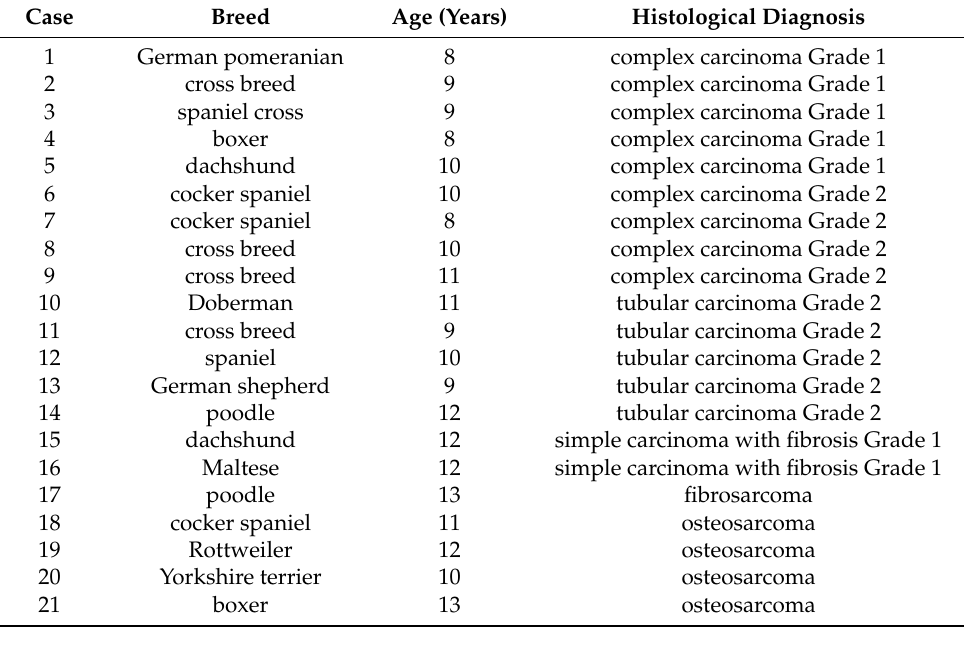
Table 2. Characteristics of canine patients enrolled in the study.